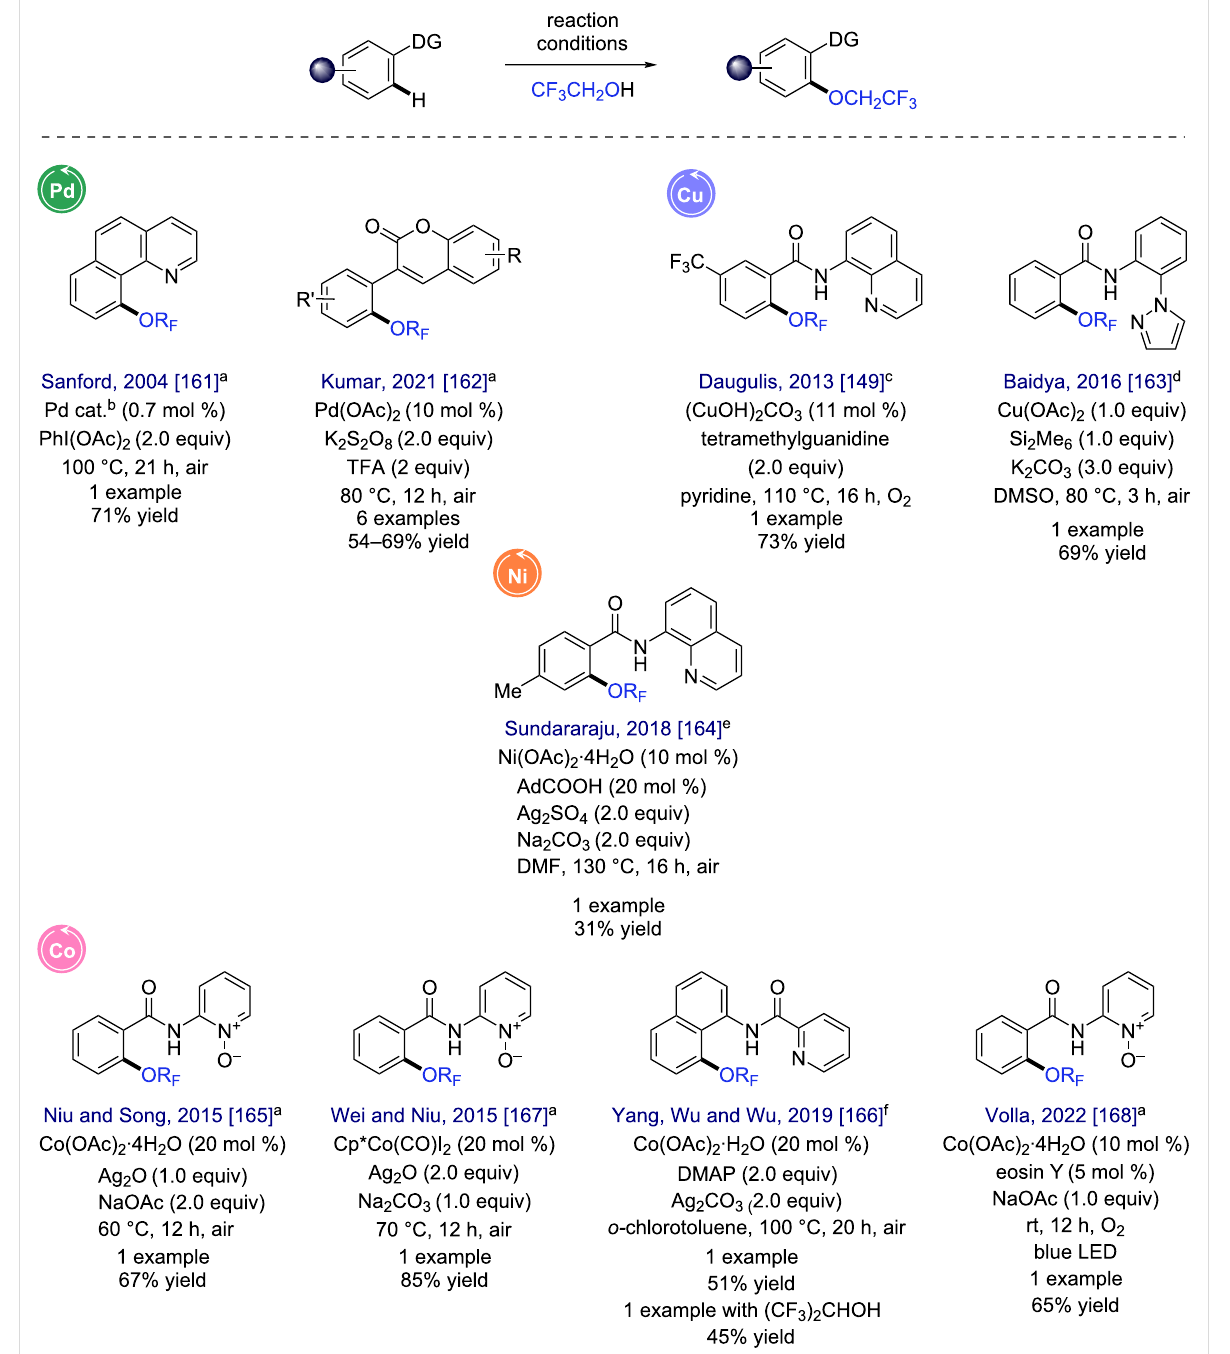
Scheme 19: Transition-metal-catalyzed dehydrogenative 2,2,2-trifluoroethoxylation of (hetero)aromatic derivatives by C–H bond activation [149]. a CF 3 CH 2 OH was used as solvent. b Pd cat. = [Pd( μ - κ 1 -OAc)( κ 2 -N,C 10 -benzo[ h ]quinoline)] 2 . c 5 equiv of CF 3 CH 2 OH. d 15 equiv of CF 3 CH 2 OH. e